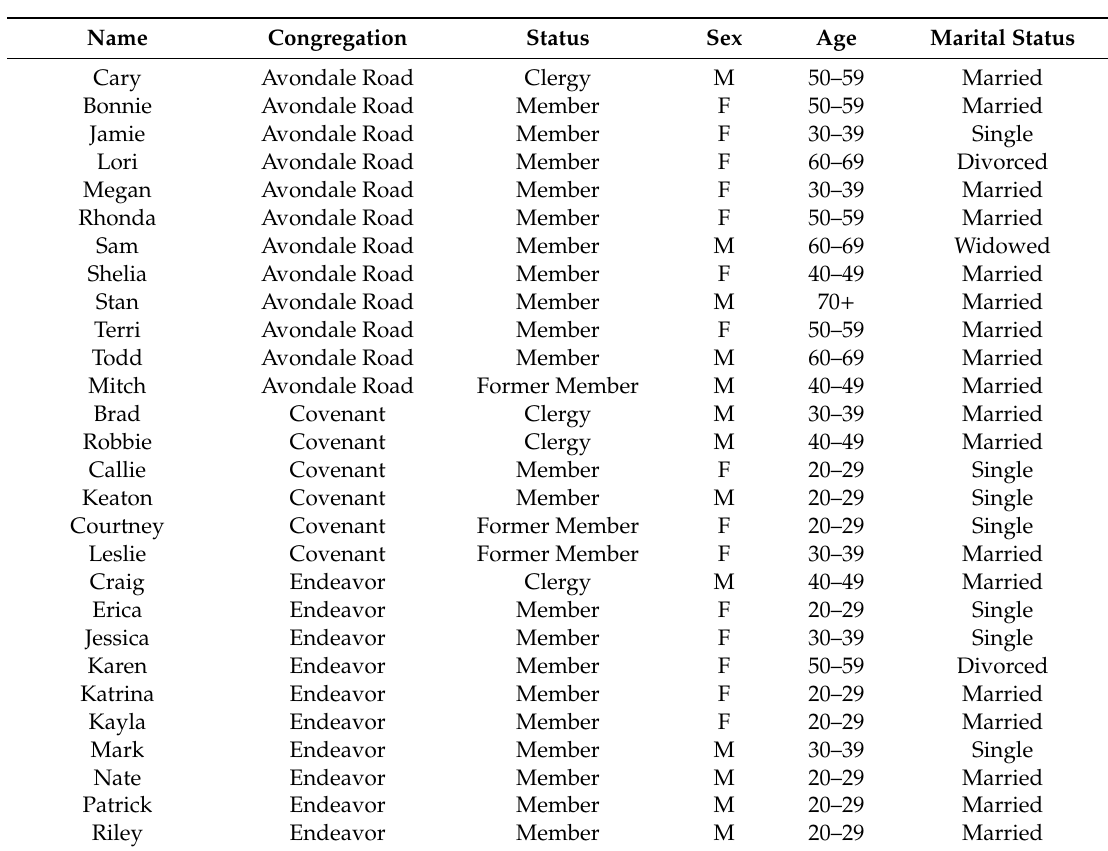
Table A2. Qualitative Interview